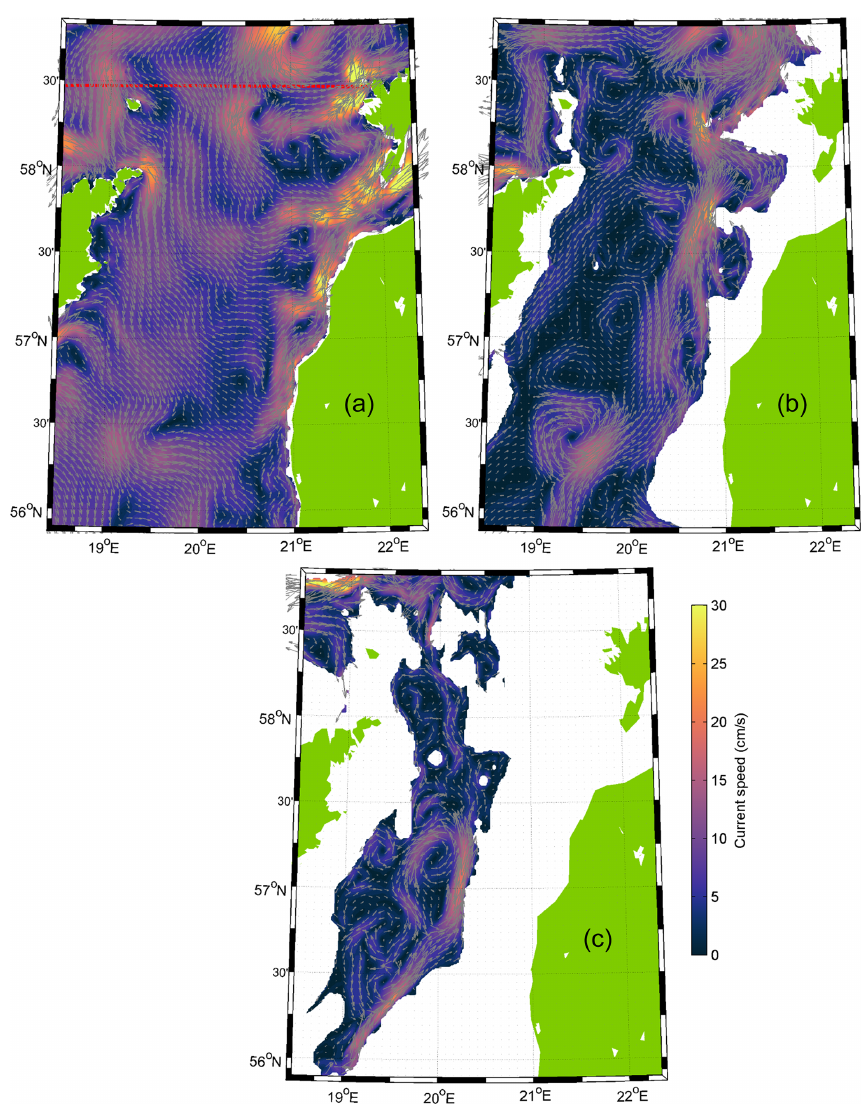
Figure 11. Mean simulated currents in the case of prevailing southwesterly winds from 2 to 7 July 2020 with the thermocline at 5 (a) , 40 (b) , and 110m depth (c) . The color scale shows current speed in centimeter per second (cms − 1 ). The red dashed line in panel (a) shows the location of the transect presented in Figs. 8 and